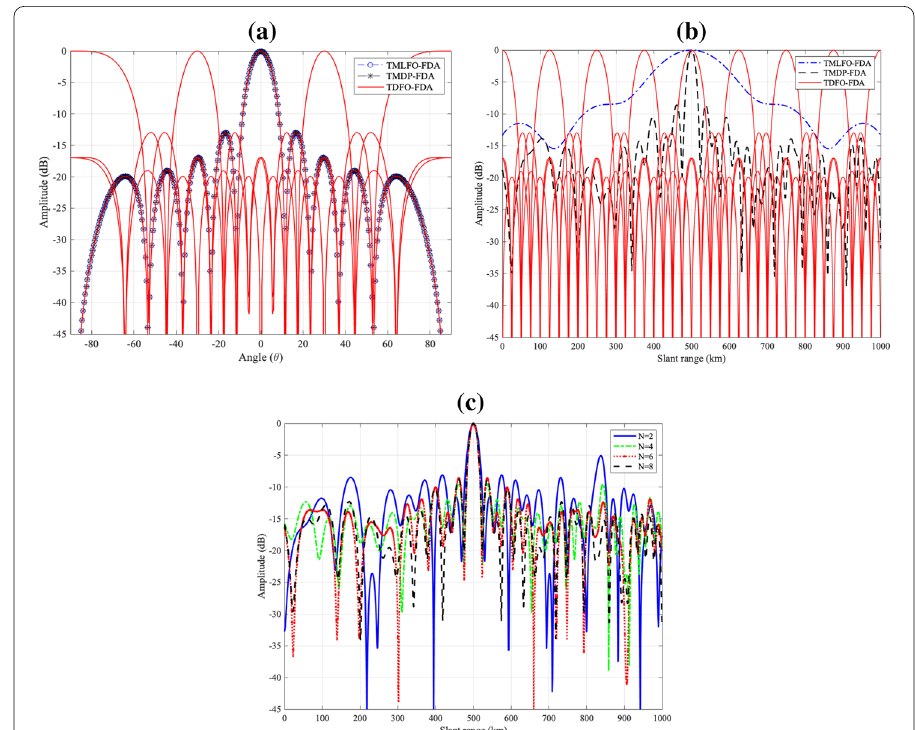
Fig. 10 Comparison of beampatterns in a angle dimension. b range dimension. c TMDP‑FDA with varying numbers of carrier